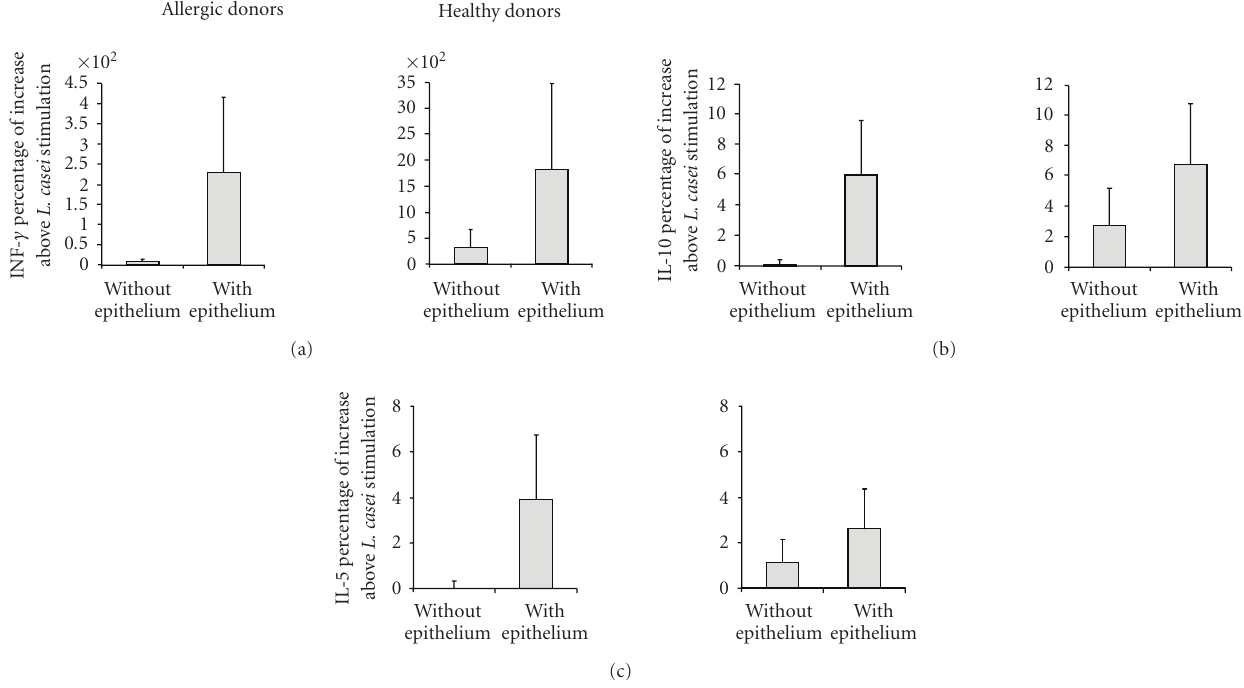
Figure 5: Production of cytokine by na¨ıve CD 4 + T cells . Monocyte-derived DC from allergic patients and healthy donors were incubated with L. casei or medium only for 24 hours, either directly in contact with cells (without epithelium) or through an intestinal epithelial layer (with epithelium). Adherent DC were harvested from the lower chamber of the Transwell, cultured with na¨ıve autologous CD4 + T cells for 5 days. Supernatants were collected and the amounts of IFN- γ , IL-10, and IL-5 were measured by specific ELISA. Results are expressed as mean ± SEM of cytokine percentage increase above L. casei stimulation ( n = 5 for both allergic and healthy